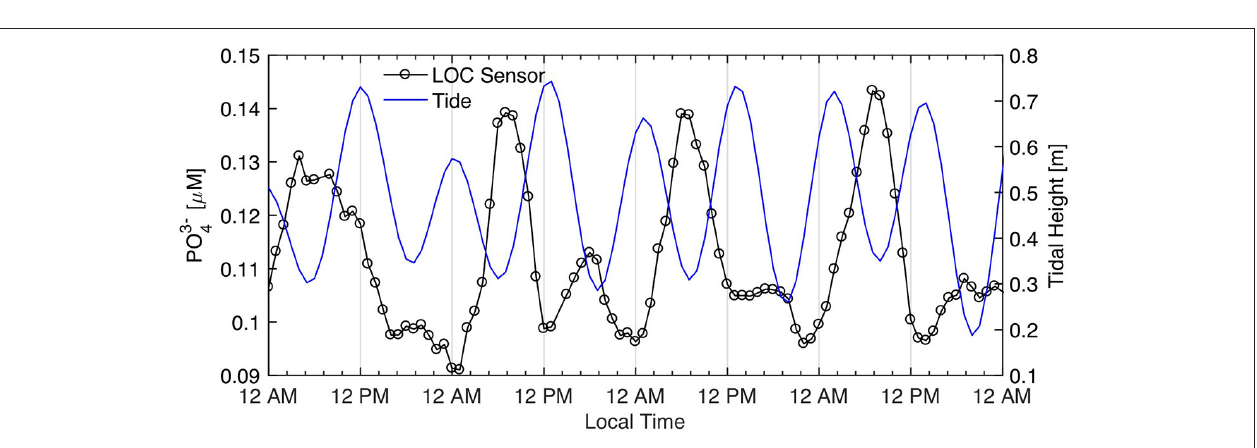
FIGURE 12 | Potential diurnal phosphate variations in Kaneohe Bay. Data from October 12–16, 2016. Sensor phosphate data were smoothed with a 6h moving average. Tide data from Moku O Loe (Coconut Island) gauging